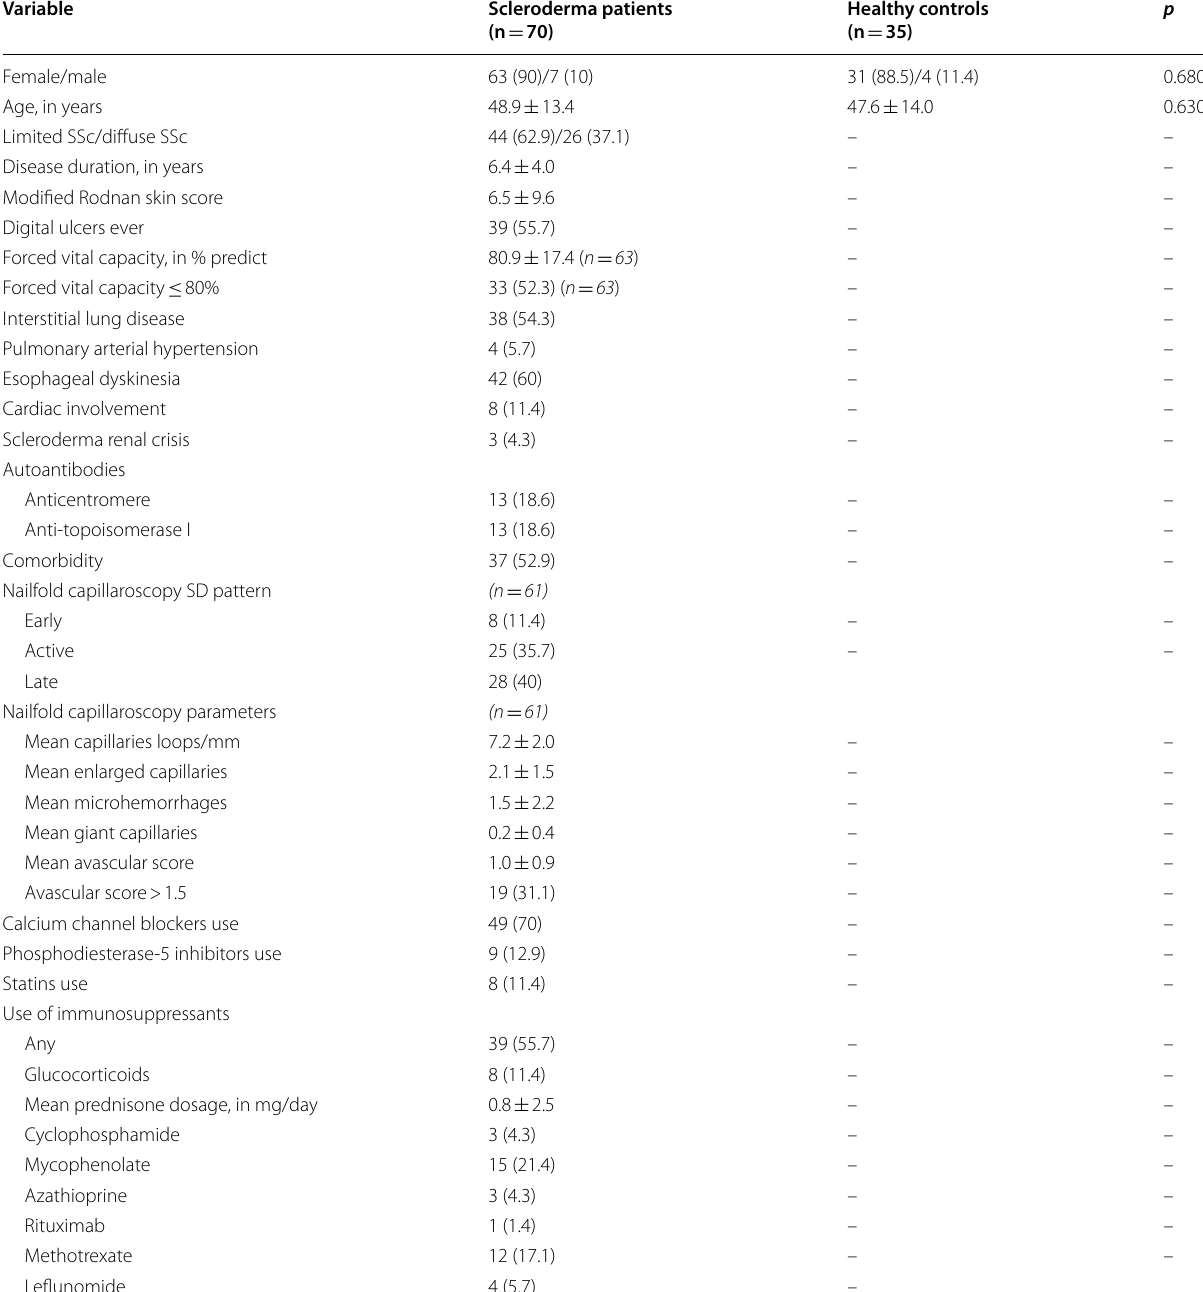
Table 1 Demographic and clinical features of patients with systemic sclerosis and